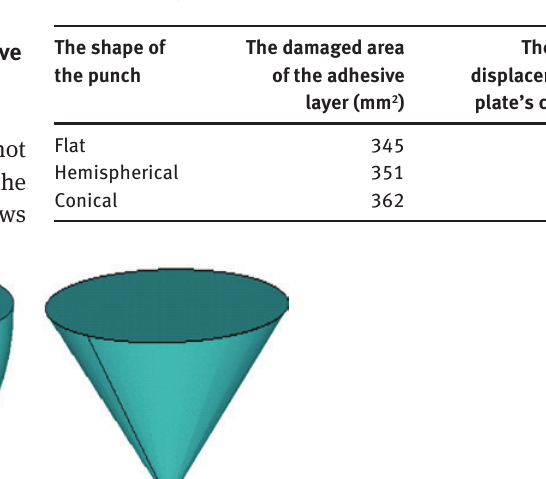
Figure 17: The variations of punch kinetic energy as a function of time.